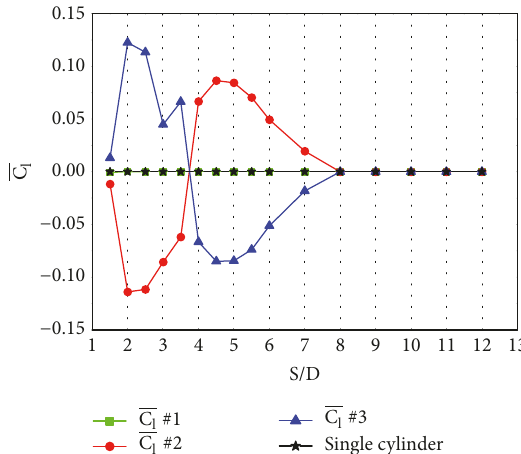
Figure 23: Variations of St with different spacing distances for three